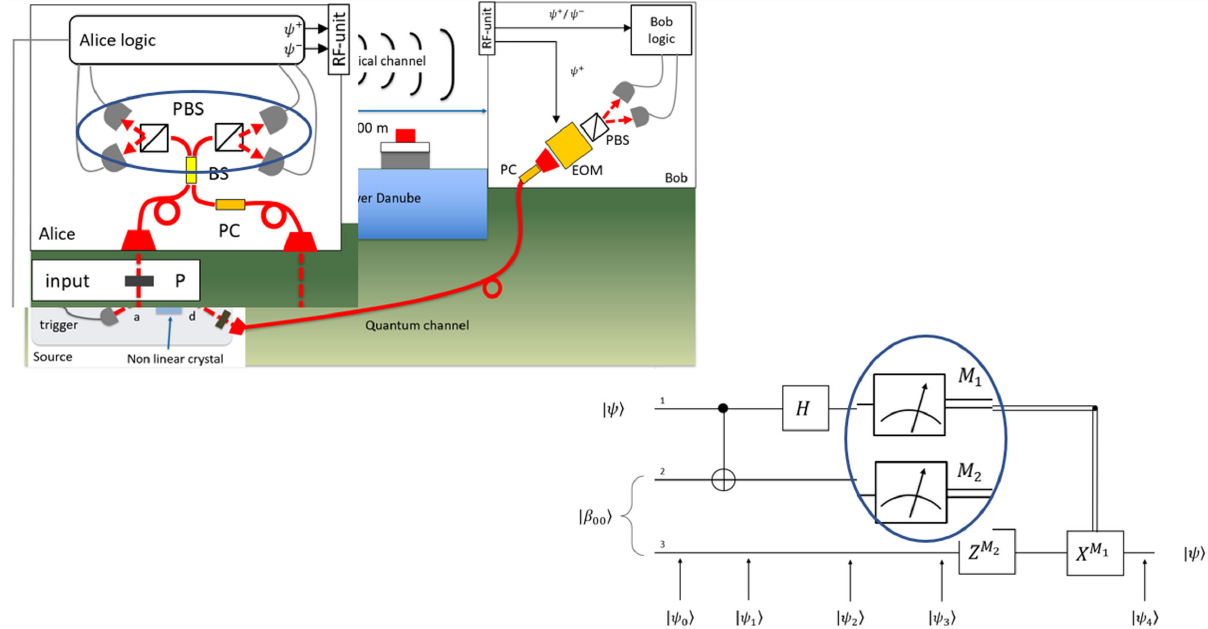
FIG. 15. Comparison between the experimental and computational